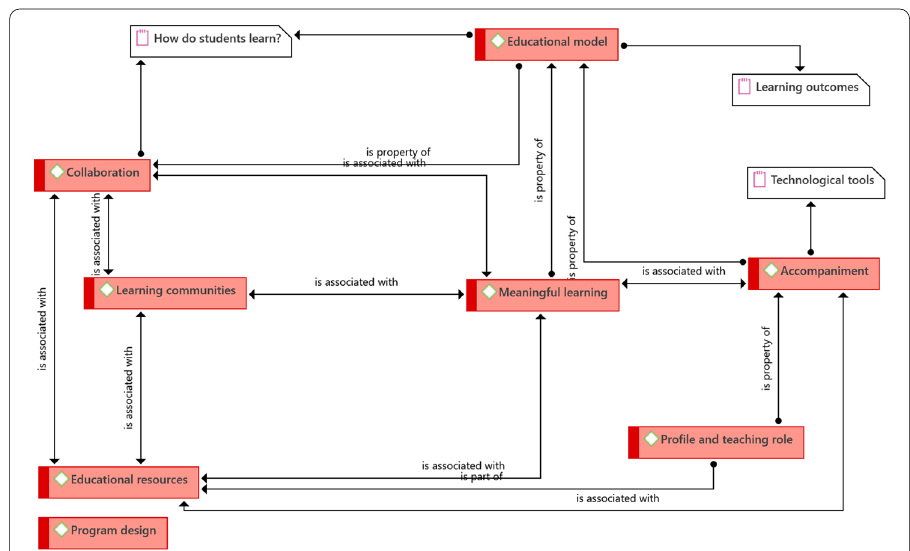
Fig. 2 Structure of driving ideas that guide what they do in education. Source: Diógenes